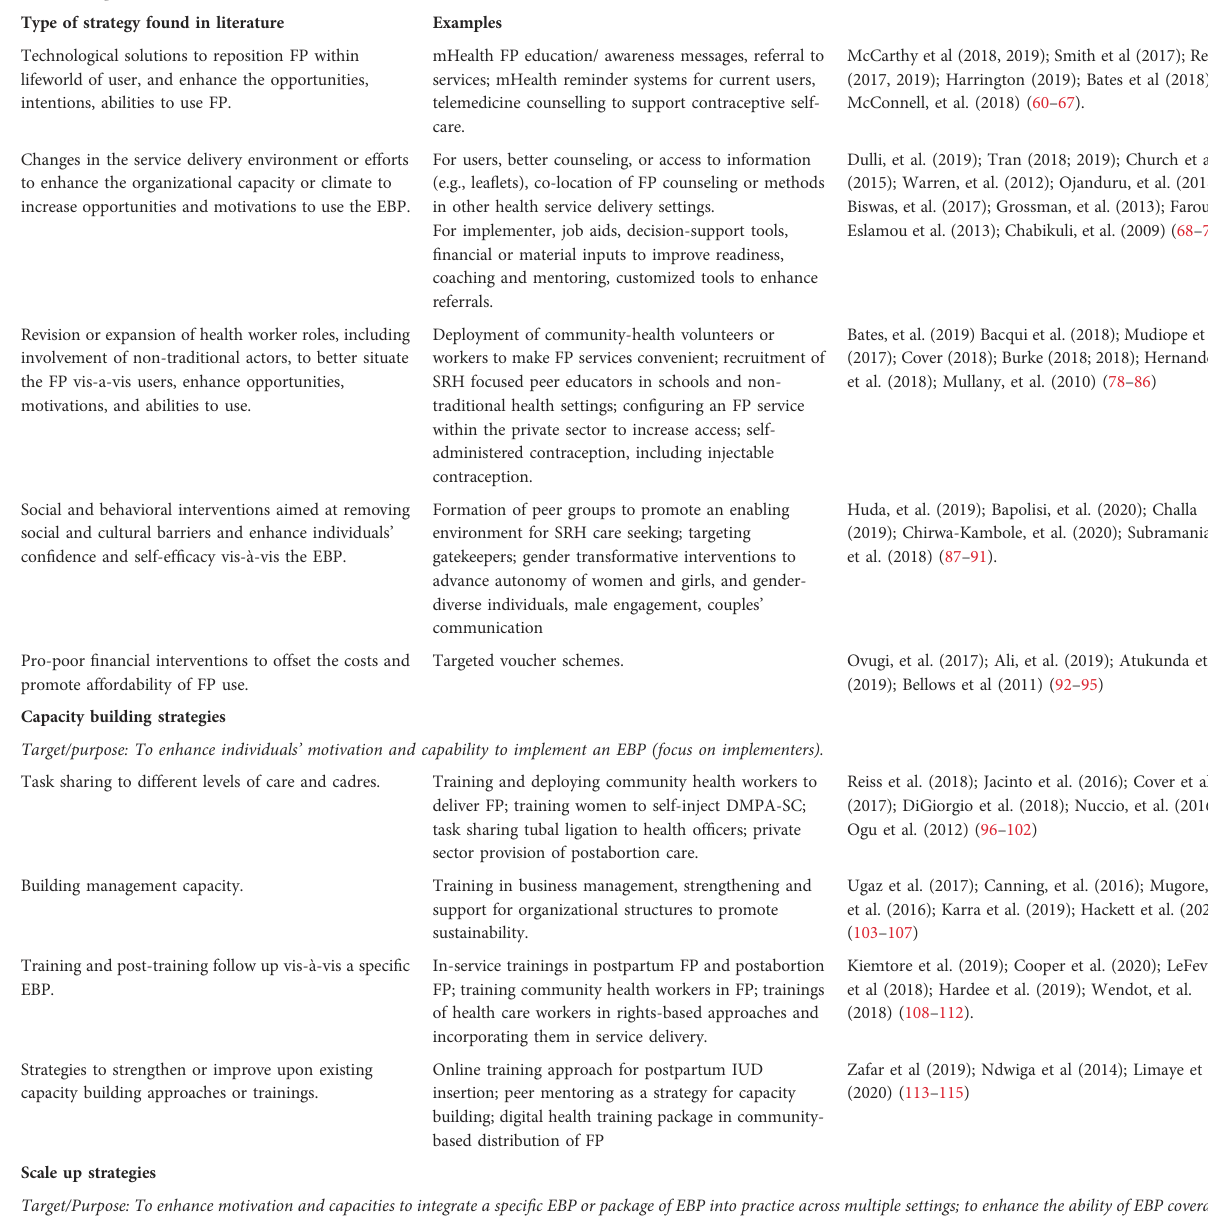
TABLE 2 Classi fi cation of implementation strategies assessed in studies included in full text review ( n =472) using the taxonomy of leeman et al. (2017) (35). Integration